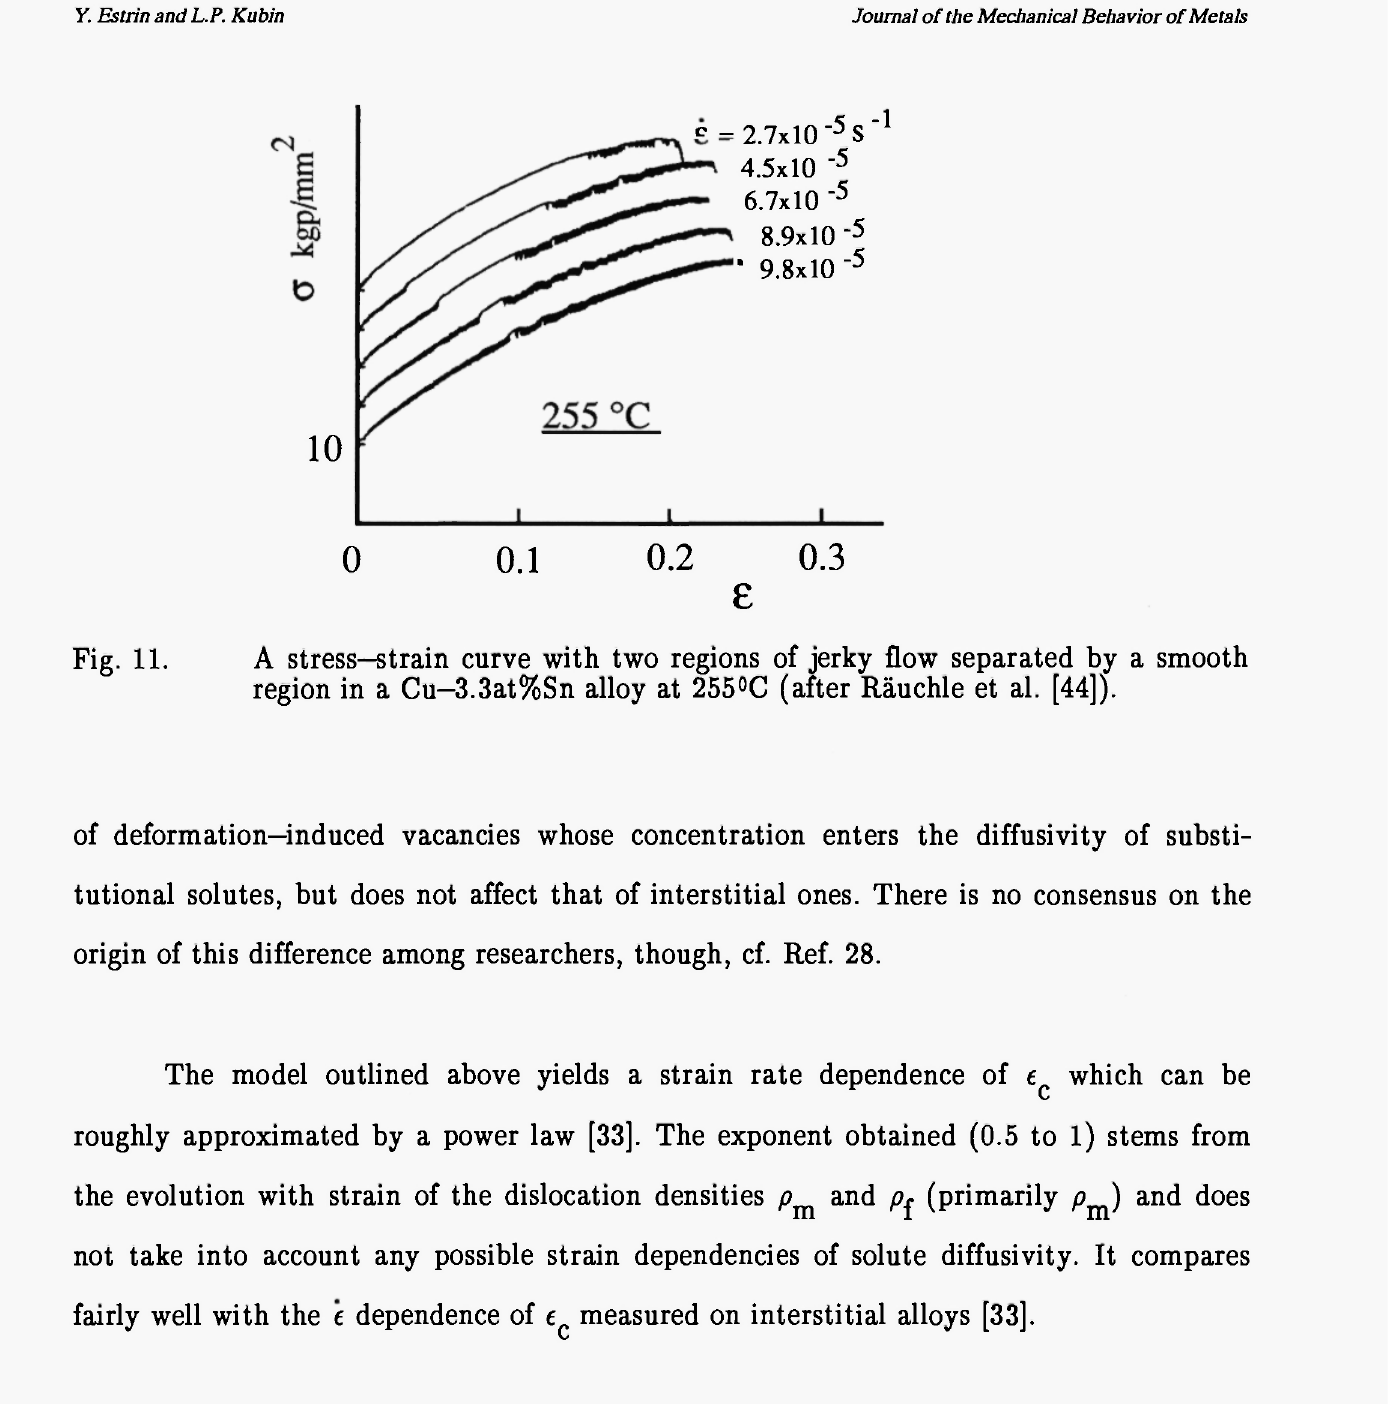
Fig. 11. A stress—strain curve with two regions of jerky flow separated by a smooth region in a Cu-3.3at%Sn alloy at 255°C (after Räuchle et al. [44]).